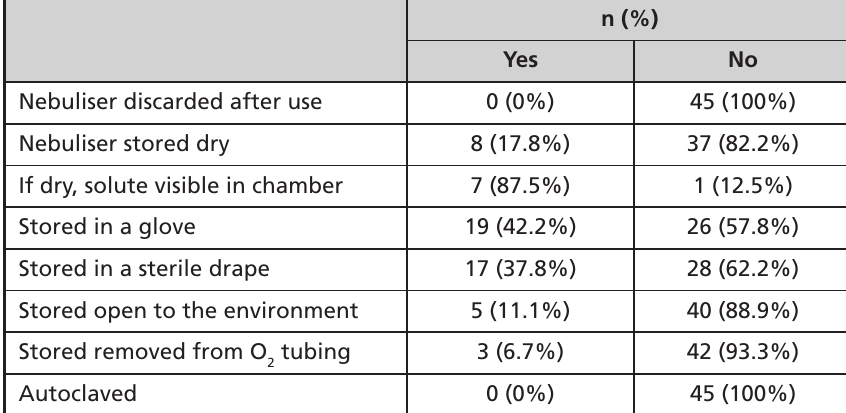
Table 3: Current Methods of Nebuliser